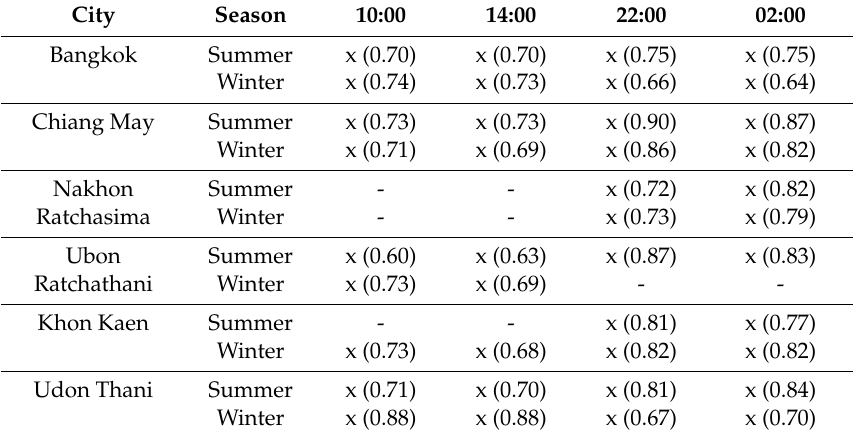
Table 1. Correlation coefficient r between SUHI from MODIS (MODerate Resolution Imaging Spectroradiometer) and Gaussian surface for the six cities. The mean r value over the years 2003–2016 is reported in brackets. x = reliable Gaussian fit; - = no Gaussian